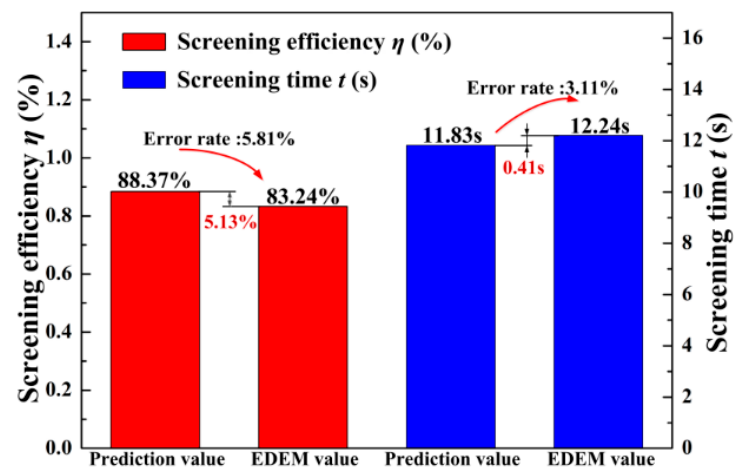
Figure 17. Value of prediction and EDEM of screening e ffi ciency and screening time.